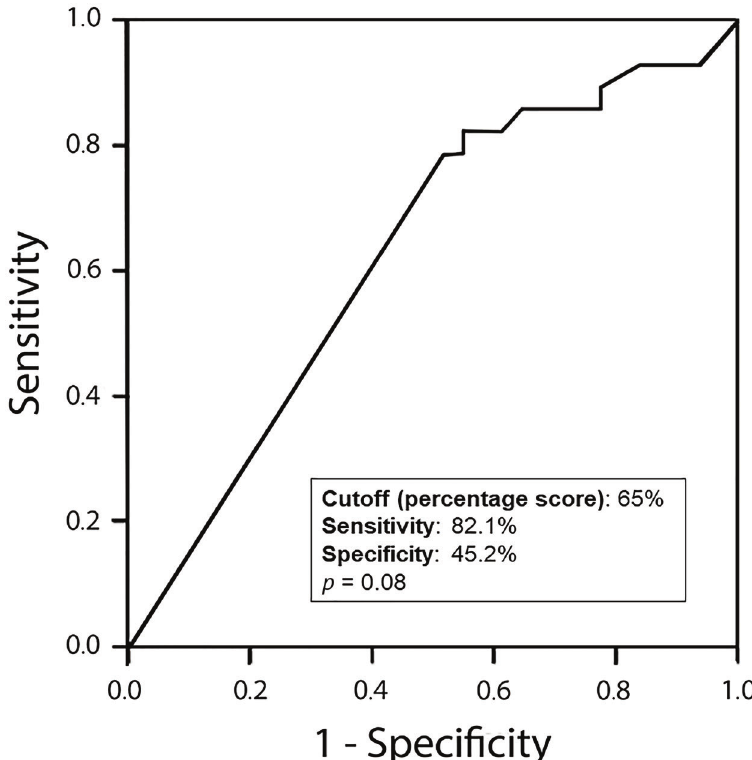
Figure 3 - ROC curve of the percentage of positive cells to discriminate enchondromas from low-grade chondrosarcomas. Accuracy, 63.00%; 95% CI, 48.60–77.30; cut-off value, 65.00%; sensitivity, 82.10%; specificity, 45.20%; p =0.0880. ROC, receiver operating characteristic; CI, confidence